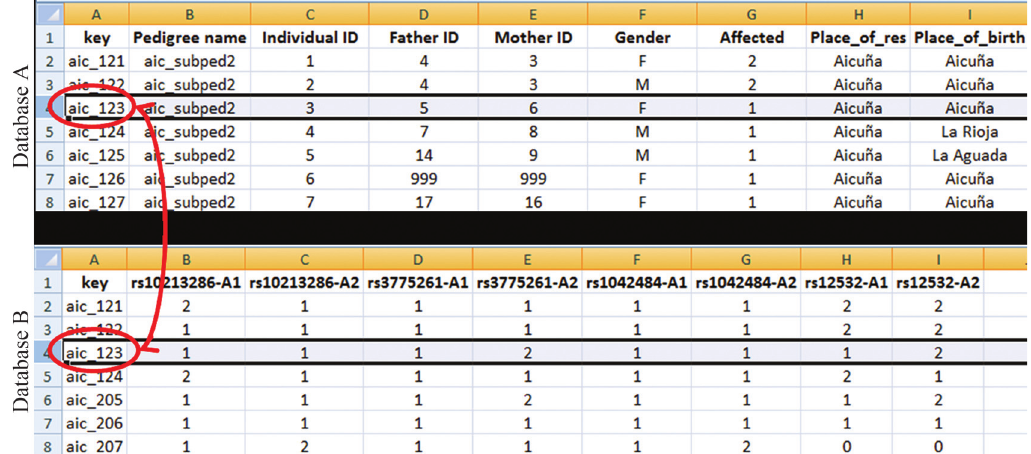
Figure 2 - A “key” variable enables the merging of different data sets into customized job files according to specific requirements for data